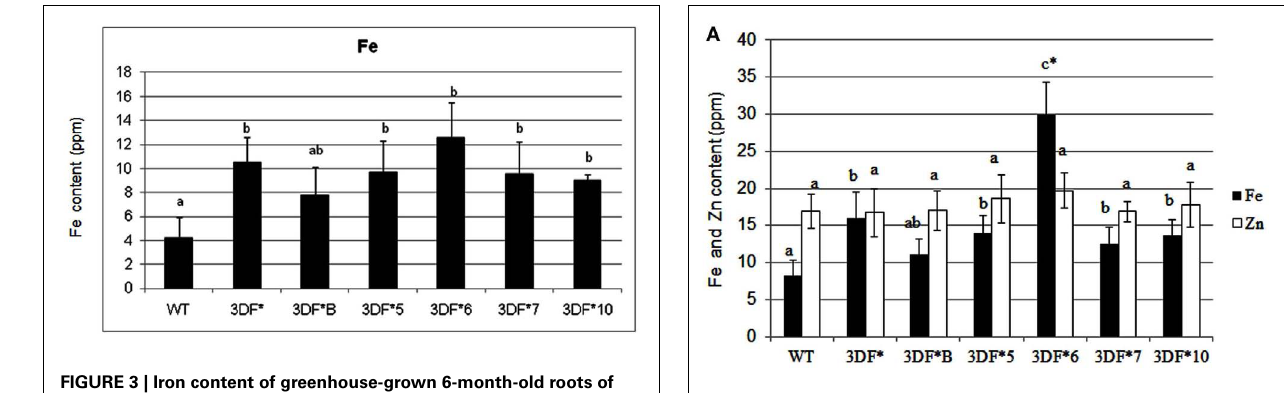
FIGURE 3 | Iron content of greenhouse-grown 6-month-old roots of FEA1 transgenic and wild-type cassava plants. The results represent the mean of three replicates ( ± standard deviation).WT, wild typeTMS 60444 cassava; 3DF*, 3DF*B, 3DF*4, 3DF*5, 3DF*6, 3DF*7, and 3DF*10 are FEA1 transgenic cassava plants. Iron content is expressed as ppm = mg Fe/kg dry weight. *Numbers with same letters show no statistical difference, different letters indicates statistically significant difference at 95% confidence level.